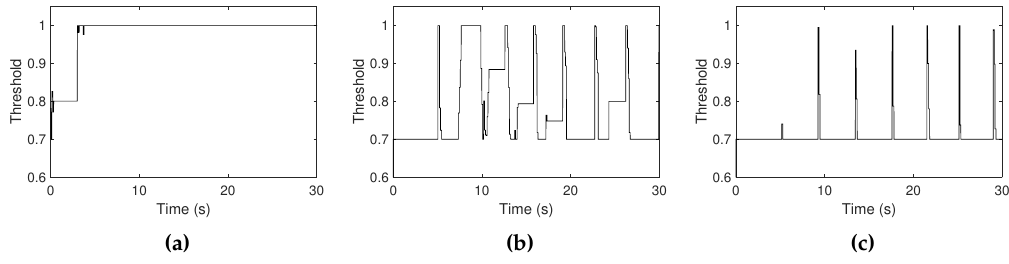
Figure 15. High threshold curves measured when the volume level of ambient noise is measured as ( a ) − 25 dB, ( b ) − 30 dB, and ( c ) − 47 dB. The range of the high threshold is constrained between 0.7 and